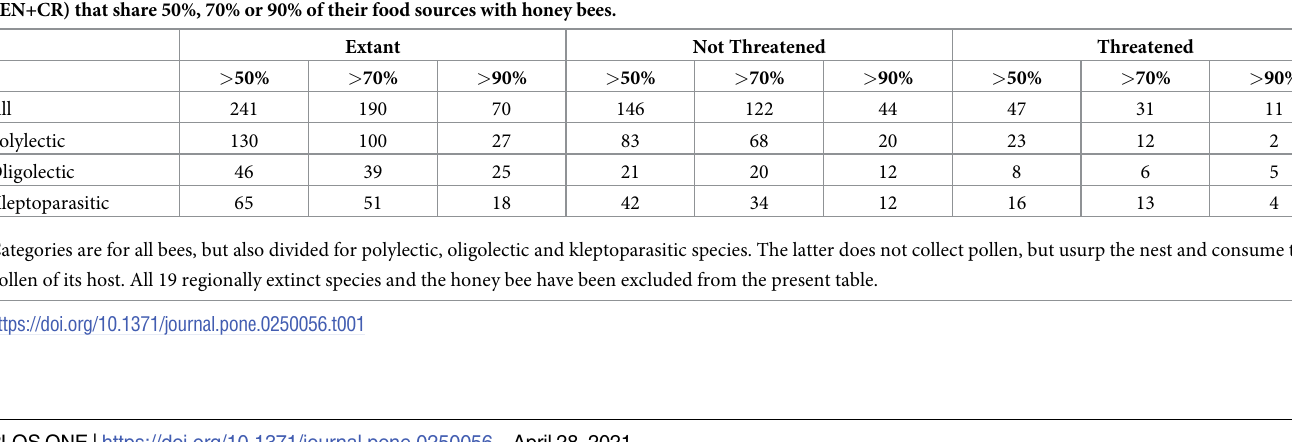
plants with the honey bee (Table 1). However, level of pairwise niche overlap, excluding the honey bee, did not differ significantly among polylectic, oligolectic, and kleptoparasitic species (Kruskal-Wallis: H = 0.16, df = 2, p = 0.92) (Fig 3), families (Kruskal-Wallis: H = 7.51, df = 5 , p = 0.19) or genera (Kruskal-Wallis: H = 36.09, df = 31, p = 0.24), nor did Danish Red List categories differ in level of pairwise niche overlap (Kruskal-Wallis: H = 11.99, df = 7, p = 0.10). Overlap of modules in the bee-plant networks In the network, excluding 118 plant genera visited exclusively by the honey bee, I = 3,378 bee- plant interactions were listed between B = 282 bee species and p = 292 plant genera visited by wild bee species. Hence, connectance C = 100 I /( BP ) = 4.10%. Plant genera interacted with an average ± SD of 11.57 ± 16.82 (range 1–109) bee species; the most generalized plant genus being Taraxacum . Bee species interacted with an average of 11.98 ± 13.16 plant genera (range 1–176), with Apis mellifera being the most generalized species, far exceeding the second most generalized bee species, Andrena flavipes (58 interactions). The network was significantly modular ( p < 0.0001), when compared to null networks. The level of modularity was 0.373 ± 0.004 ( N = 100 runs), and the network was partitioned into an average of 5.16 modules (4 modules in 3 runs, 5 modules in 78 runs, 6 modules in 19 runs) (Fig 5). A total of 35 plant genera shared their module with the honey bee in all runs of the modu- larity analysis, while 149 plant genera never did so (Fig 4A). A total of 219 bee species were Table 1. Number of total extant species (Danish Red List categories NA+DD+LC+NT+VU+EN+CR), not threatened species (LC+NT) and threatened species (VU +EN+CR) that share 50%, 70% or 90% of their food sources with honey bees. Extant Not Threatened Threatened > 50% > 70% > 90% > 50% > 90%